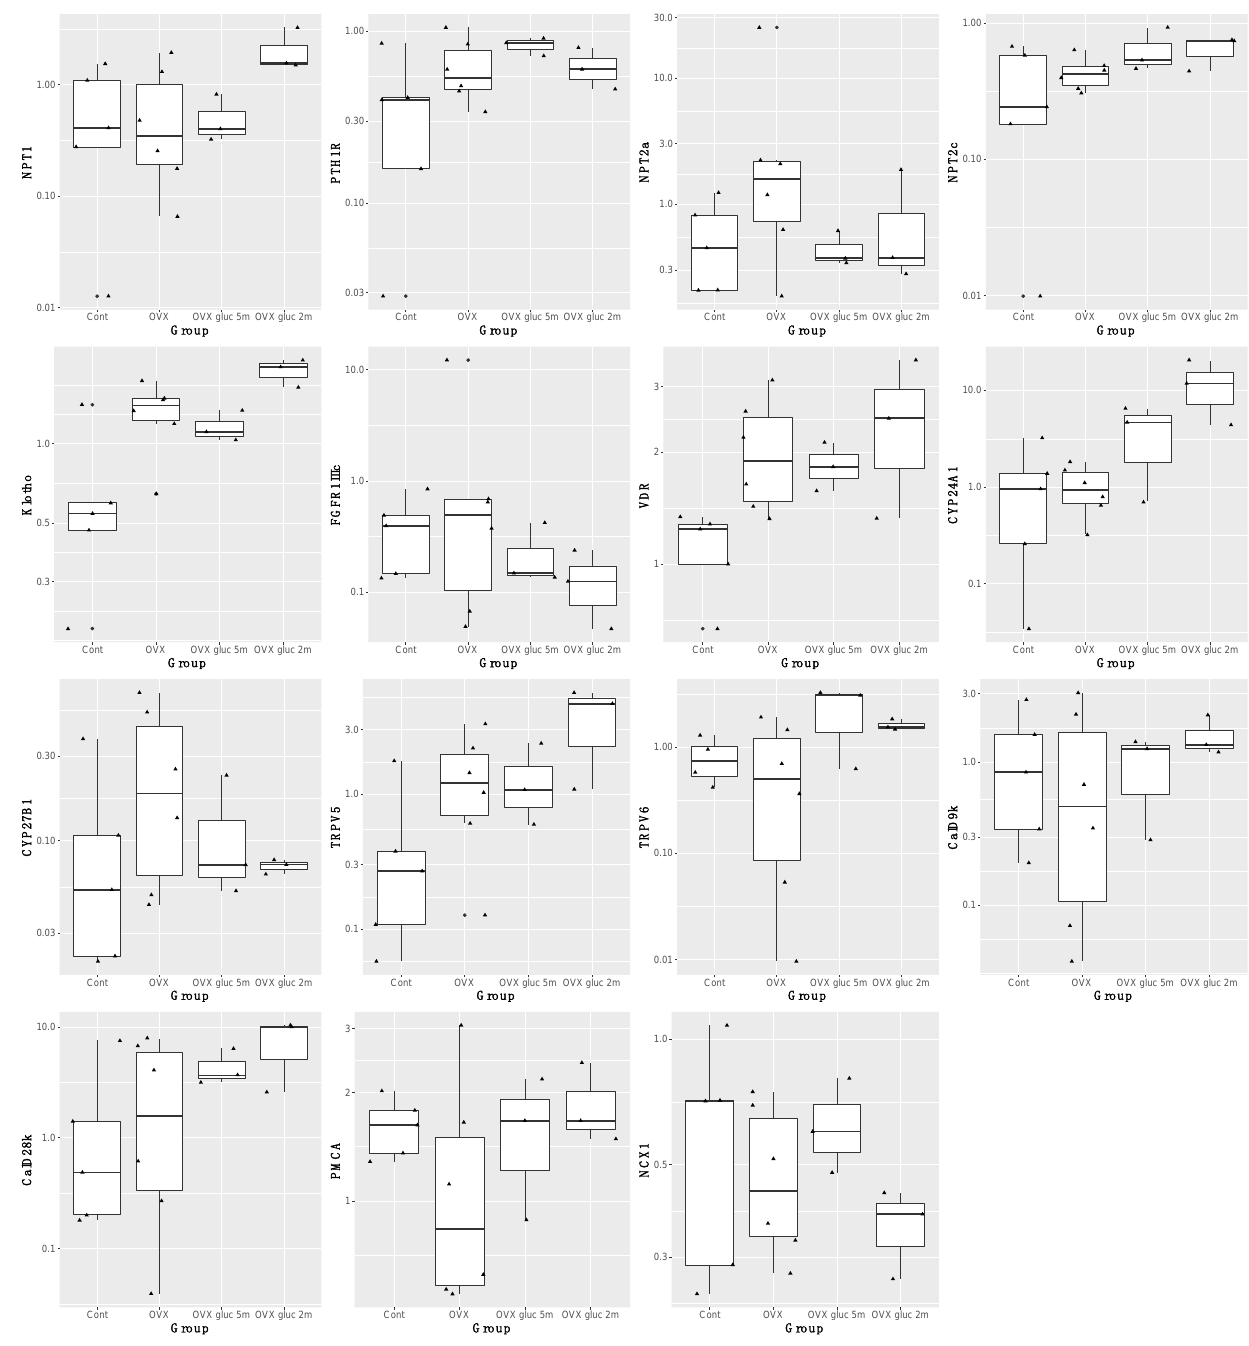
Figure 3. Boxplot of log 10 transformed renal gene fold expression in control (Cont), ovariectomized (OVX), ovariectomized and treated with glucocorticoids for 5 months (OVX gluc 5m) and ovariec- tomized and treated with glucocorticoids for 2 months with 3 months recovery (OVX gluc 2m), all euthanized at 5 months. Genes examined include sodium-phosphate co-transporters ( NPT1 , NPT2a , NPT2c ), parathyroid hormone 1 receptor ( PTH1R ), α -klotho, fibroblast growth factor receptor 1 IIIc ( FGFR1IIIc ), vitamin D receptor ( VDR ), cytochrome P450 family 24 subfamily A polypeptide 1 ( CYP24A1 ), cytochrome P450 family 27 subfamily B polypeptide 1 ( CYP27B1 ), transient receptor potential cation channel subfamily V member 5 and 6 ( TRPV5 , TRPV6 ), calbindin D9k ( CalD9k ), calbindin D28k ( CalD28k ), plasma membrane calcium ATPase ( PMCA ), sodium calcium exchanger 1 ( NCX1 ). Black circle next to triangle indicates that point is an outlier.